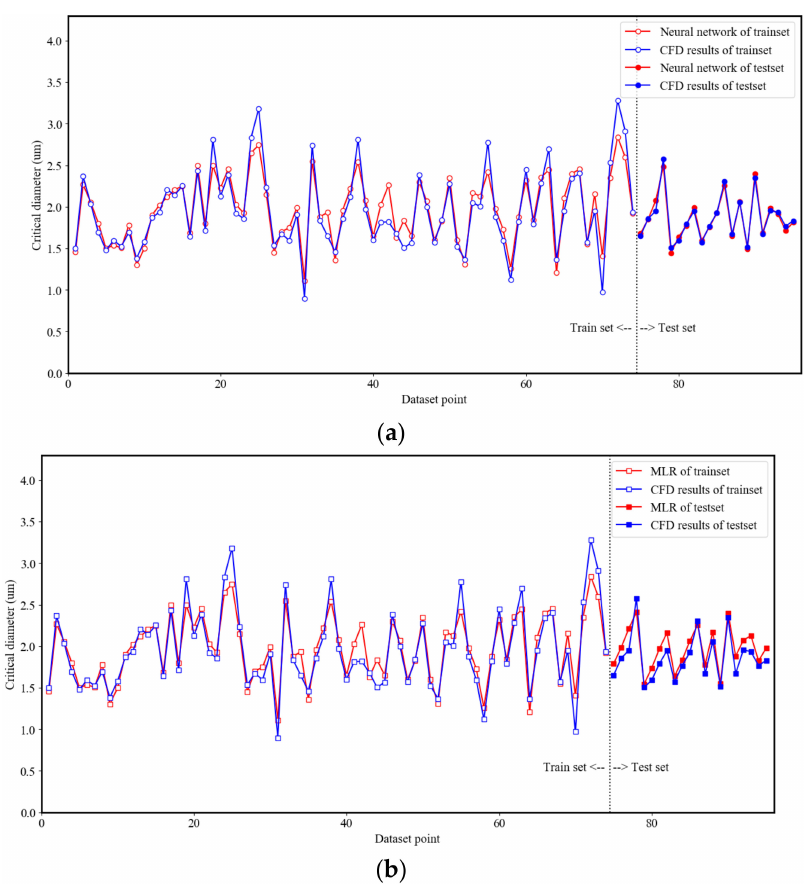
Figure 10. The result of comparing the prediction performance of the MLR model and the neural network model.